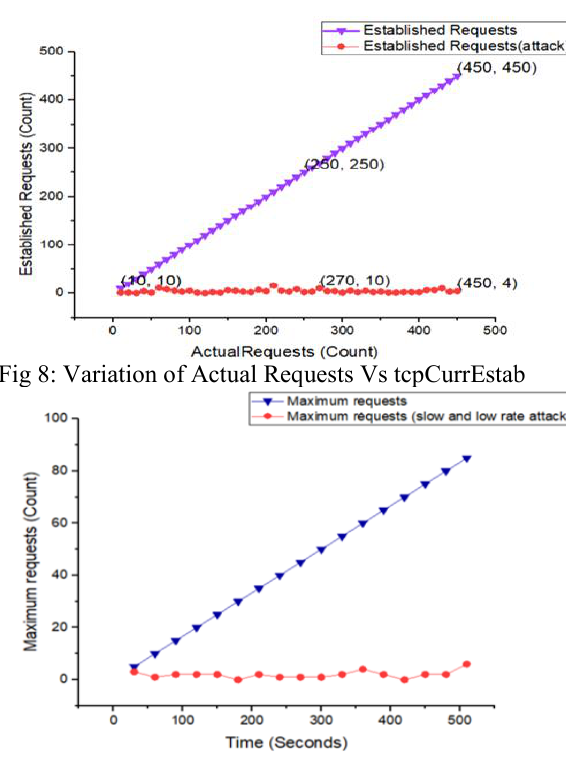
Fig 9: Variation of Time Vs Maximum